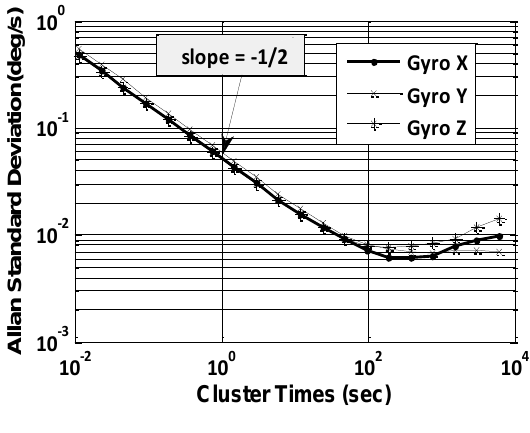
Figure 4. Allan variance for